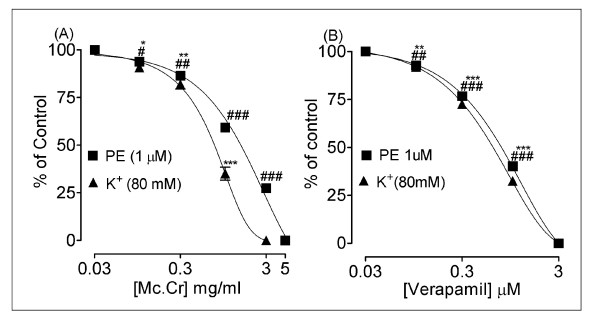
Concentration-response curves showing the vasodilator effect of Mc.Cr (A) and verapamil (B) on phenylephrine (PE 1 μM) and K+ (80 mM) induced contractions in isolated rabbit aortic preparations. #P < 0.05; ##P < 0.01; ###P < 0.001; shows a comparison of concentration-dependent effect on phenylephrine (PE 1 μM) induced contraction.*P < 0.05;**P < 0.01; ***P < 0.001; show comparisons of concentration dependent effects on K+ (80 mM) induced contractions.